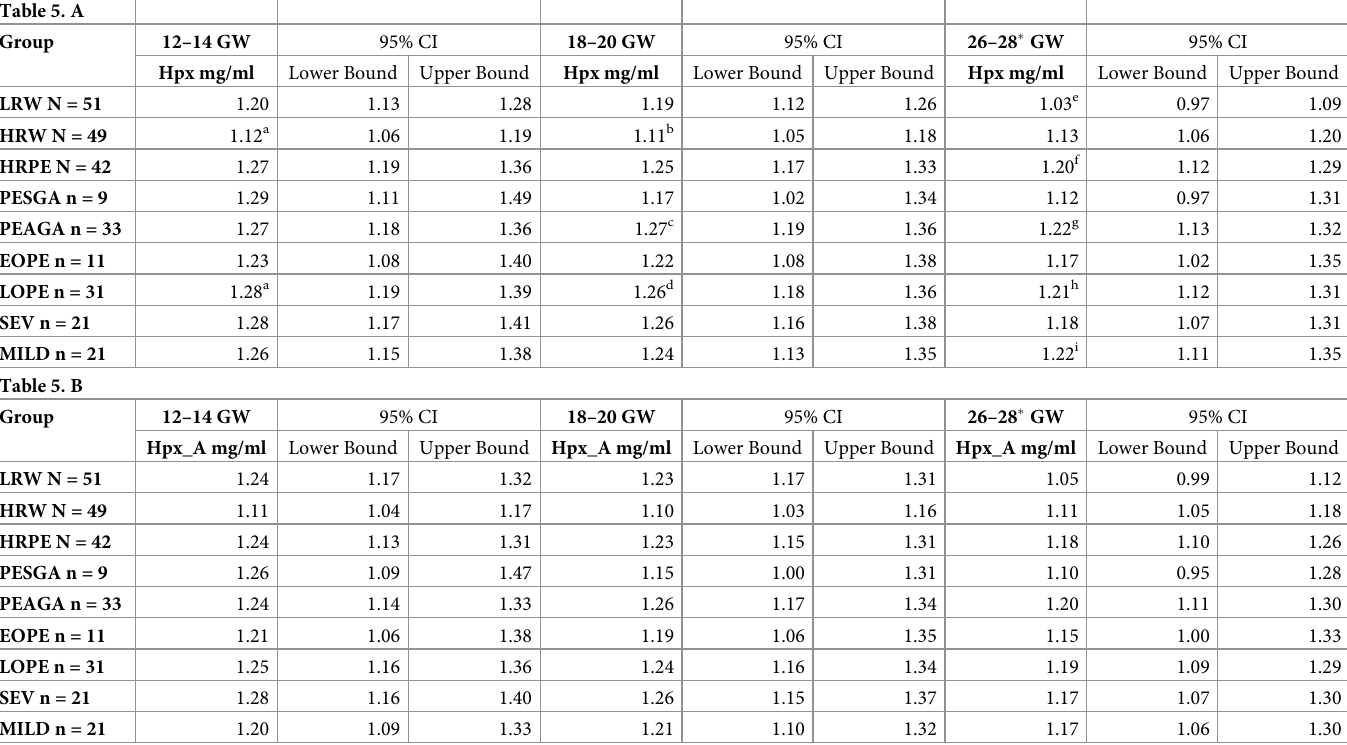
Table 5. Geometric mean plasma hemopexin concentrations (mg/ml) by subgroups at three different sampling points during pregnancy. A before adjustment for body mass index, B after adjustment for body mass index. Table 5. A